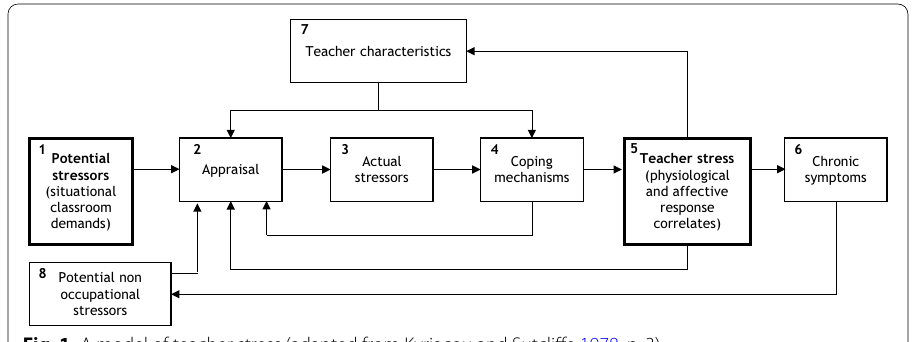
Fig. 1 A model of teacher stress (adapted from Kyriacou and Sutcliffe 1978, p.